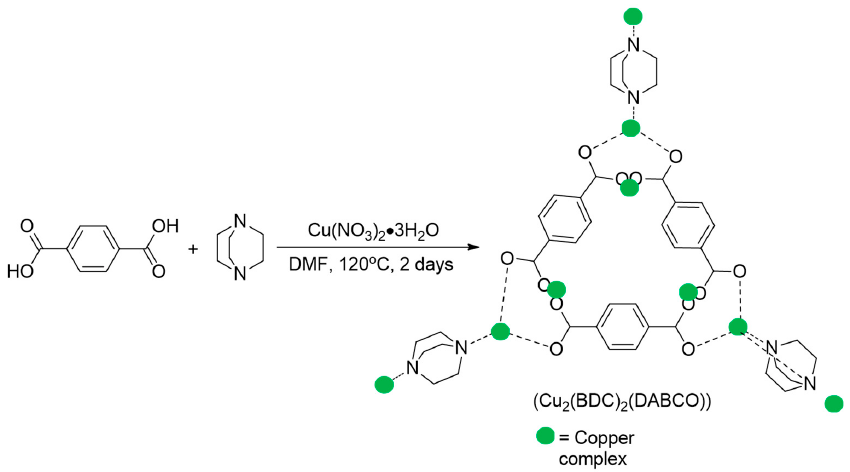
Scheme 33. Synthetic route of Cu 2 (BDC) 2 (DABCO).